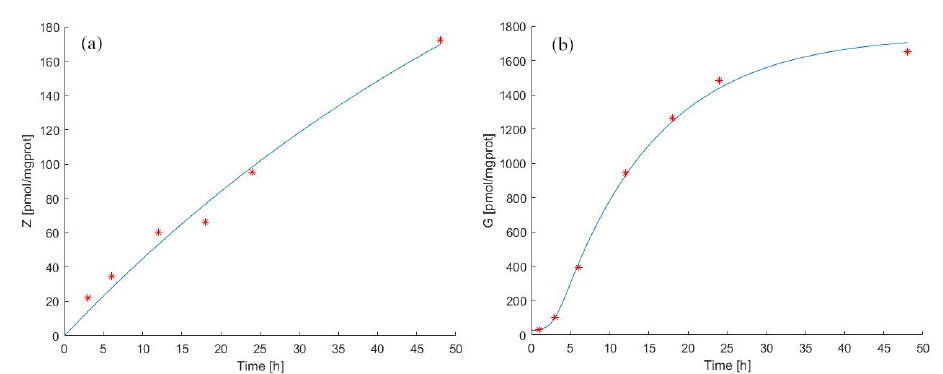
Figure 4. Model 2 simulation trend in the continuous experiment. Panel ( a ) shows the simulated zoledronate ( ZA ) trend over time; panel ( b ) shows the simulated antigen ( IPP ) trend over time. The continuous blue line represents the model forecast, while red asterisks represent the experimental data obtained by